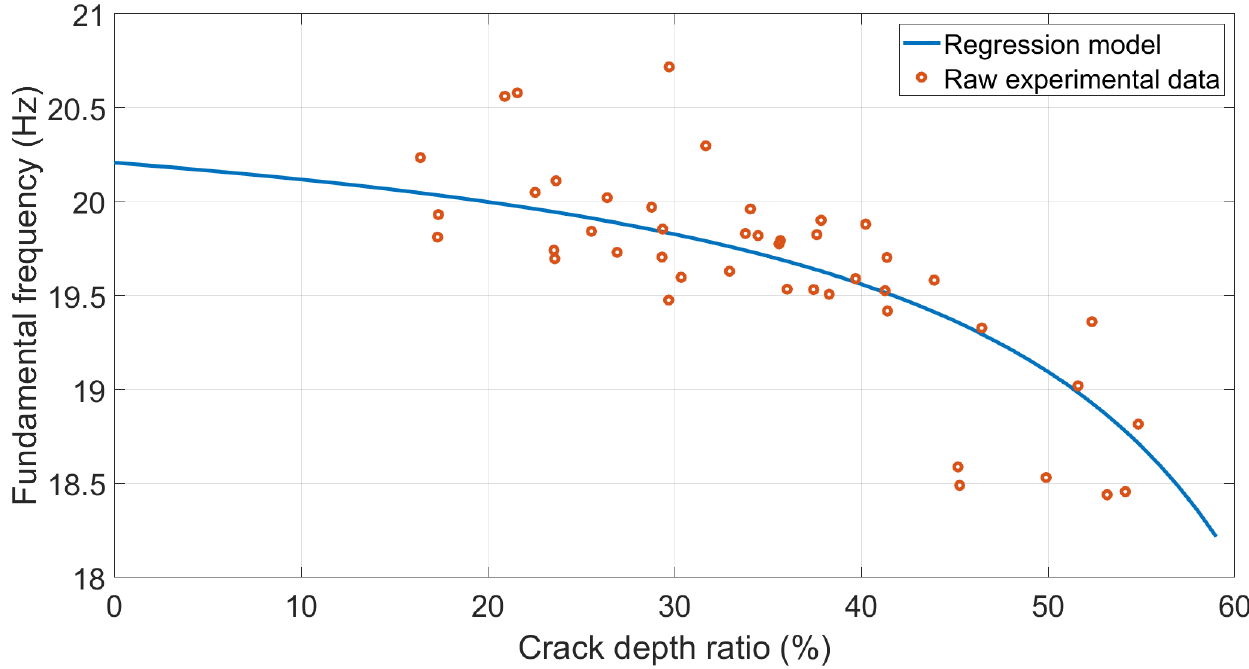
Figure 10. Regression model for torsional spring stiffness.